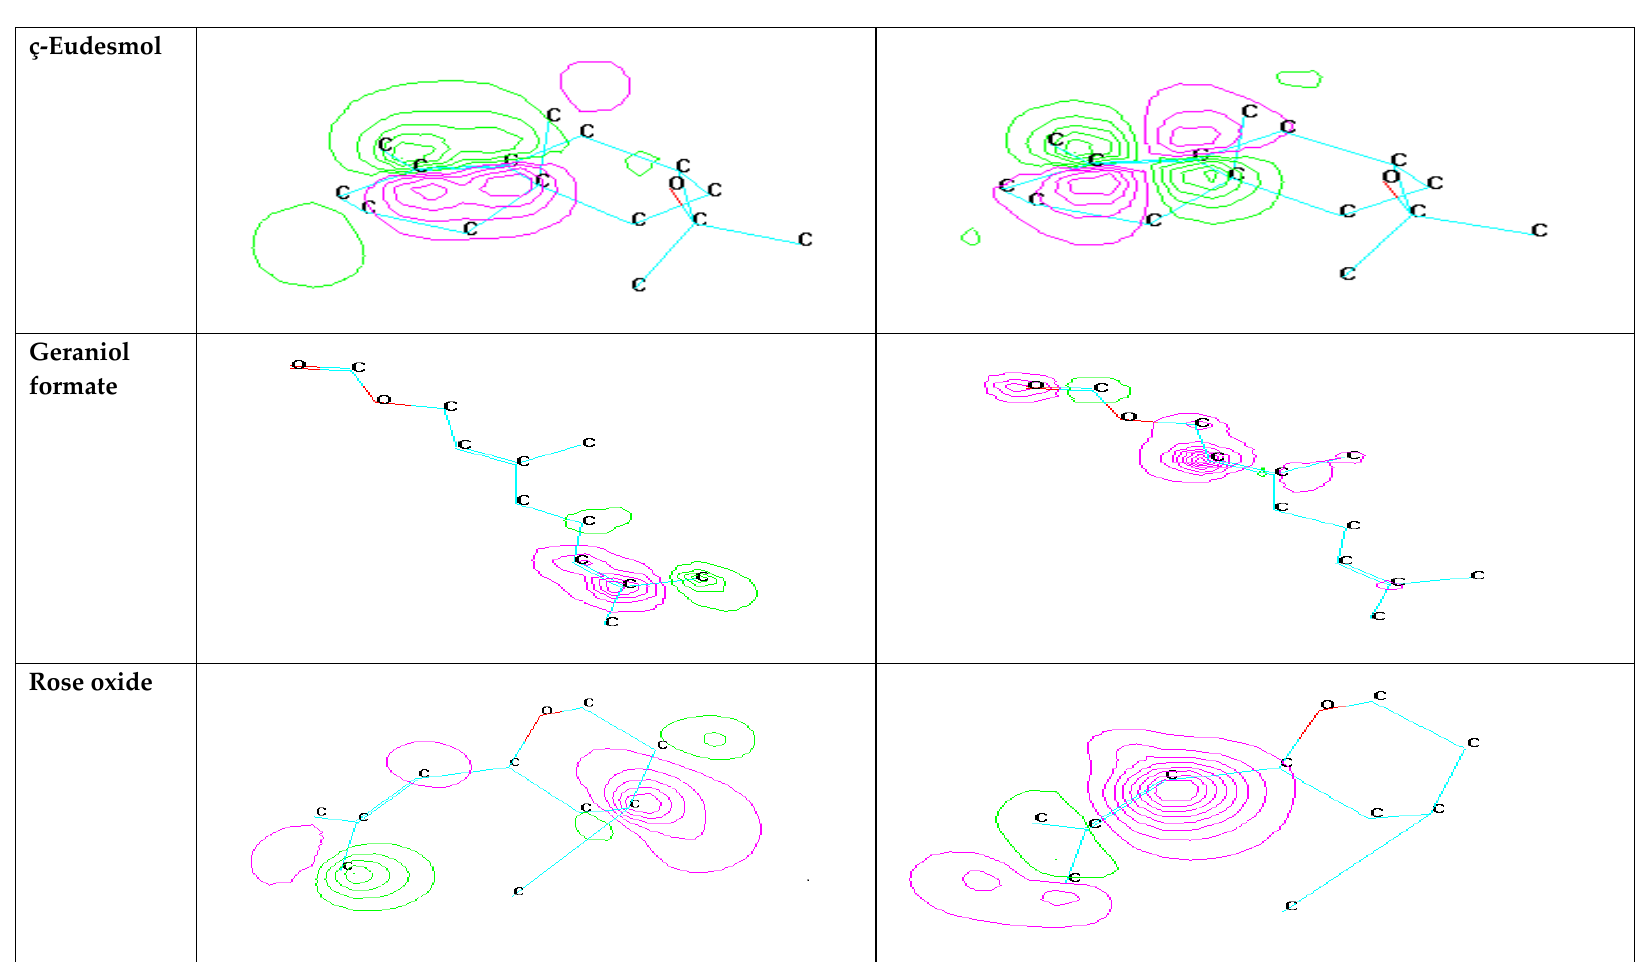
Figure 4. 2D contours HOMO and LUMO of the studied compounds using MNDO